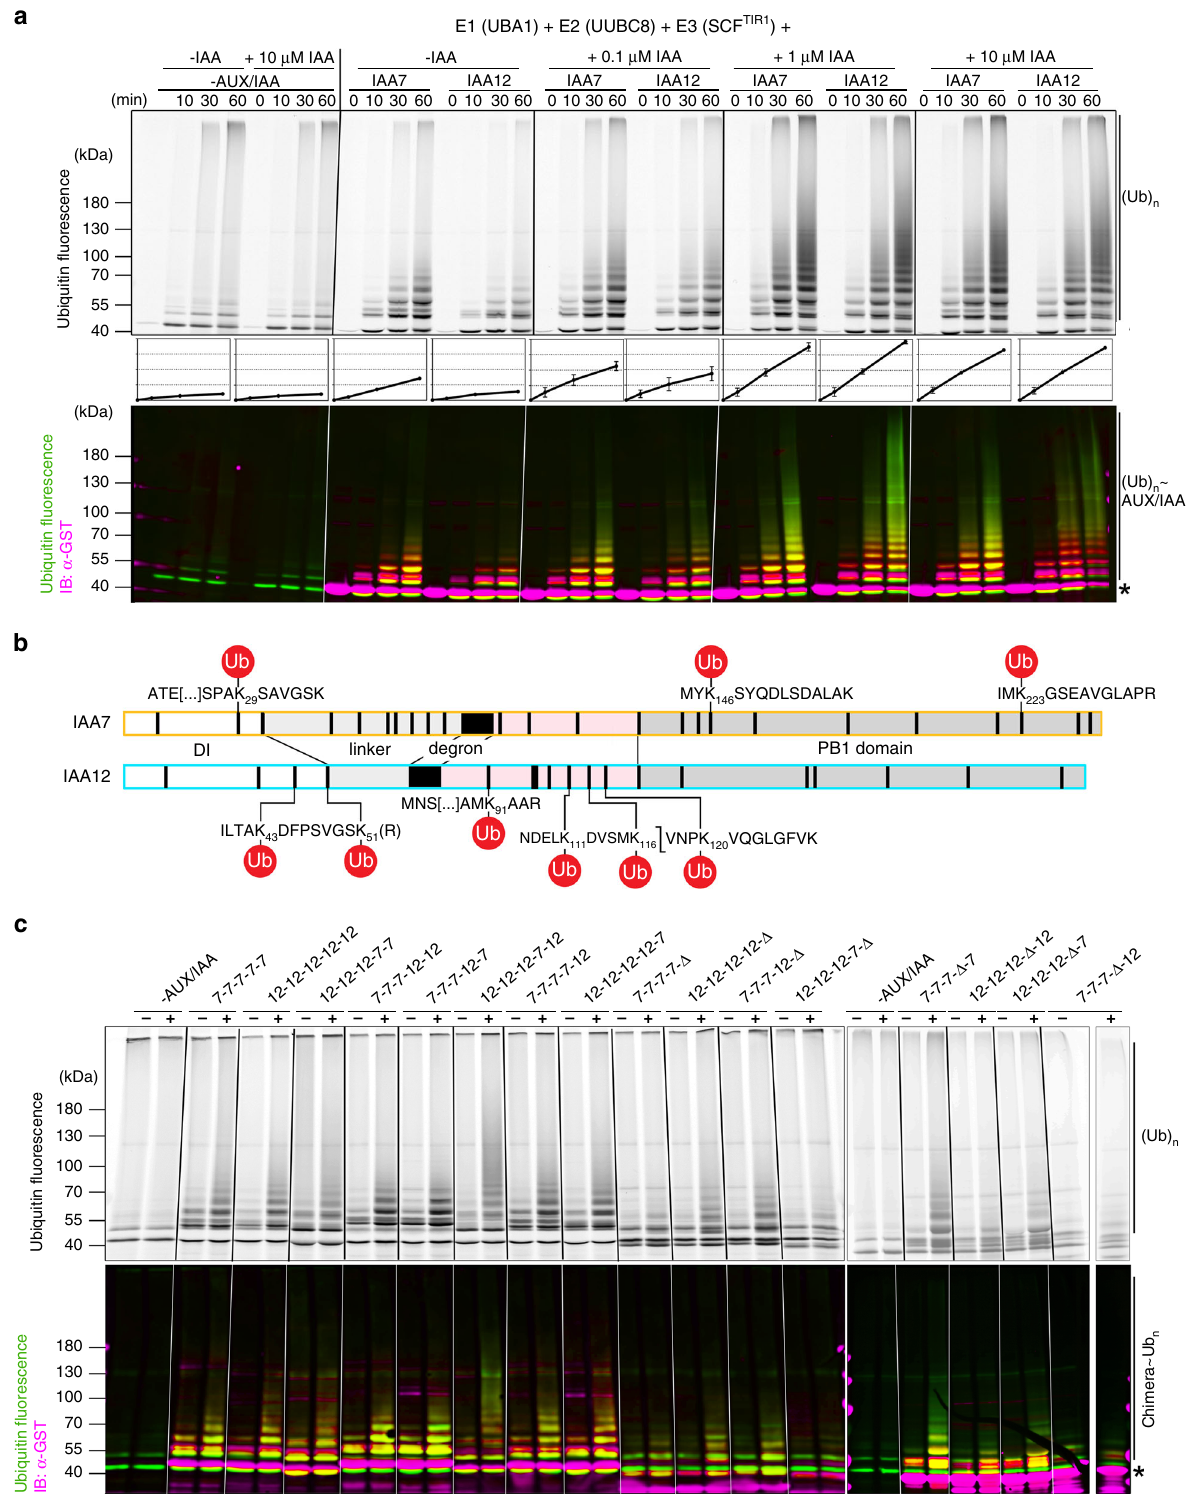
Fig. 3 Auxin-driven and SCF TIR1 -dependent ubiquitylation of IAA7 and IAA12 display distinct dynamics. a IVU assays with recombinant GST-IAA7 or GST-IAA12, E1 ( At UBA1), E2 ( At UBC8), reconstituted SCF TIR1 ( At SKP1·TIR1, Hs Cul1 and Mm RBX1), fl uorescein-labeled ubiquitin (Ub) and IAA (auxin). IAA7 and IAA12 ubiquitylation is auxin-driven and time-dependent. Ubiquitylation was monitored using the ubiquitin fl uorescent signal (green), and anti- GST/Alexa Fluor 647-conjugated antibodies for detection of GST-AUX/IAAs (magenta). ImageQuantTL software was used for quanti fi cation (middle; means ± SEM, n = 3), and generation of merged image (bottom; overlapping Ub and GST signal: yellow). b IAA7 and IAA12 IVU samples were analyzed via LC-MS, and putative ubiquitylation sites, detected by the diGly (or LRGG) Ub remnant after tryptic digest, were mapped relative to the domain structure. IAA12 Ub sites agglomerate in the region upstream of the degron (white) and the degron tail (light pink). c Ubiquitin conjugation on chimeric IAA7 and IAA12 (colors as in a ) proteins in the presence or absence of 1 µ M IAA. IVU reaction time 1 h. (*) Asterisks depict unmodi fi ed